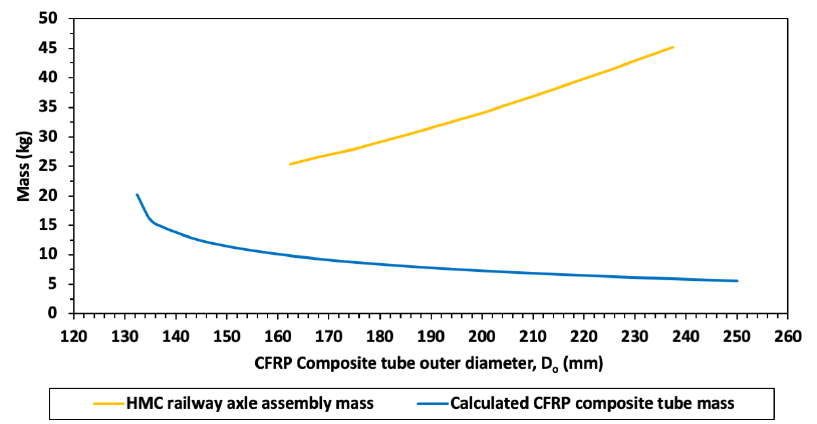
Figure 6. Reduction in the carbon fibre reinforced polymer (CFRP) composite tube mass with increasing diameter and the competing gain in the railway axle assembly mass.